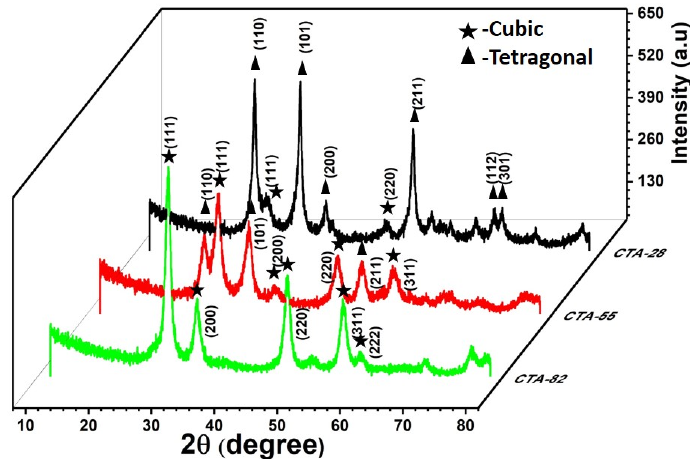
Figure 2. XRD patterns ofCTA-28, CTA-55, and CTA-82. Table 2. Microstructural properties of